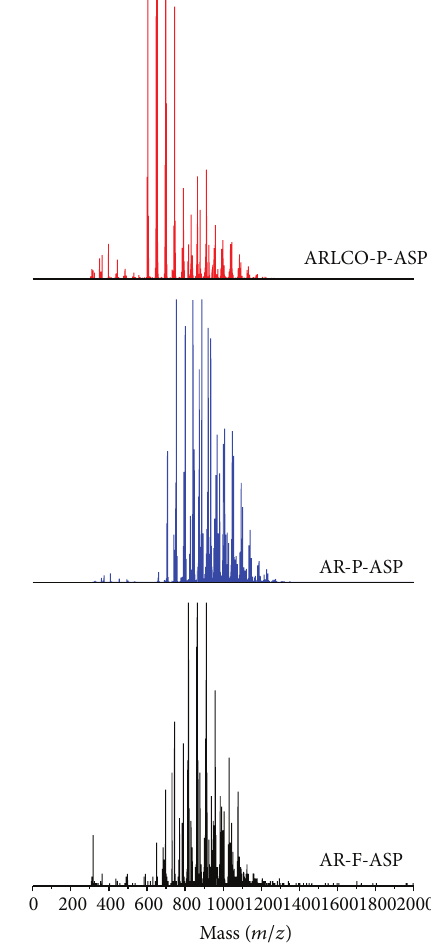
Figure 1: TOF-MS spectra of asphaltenes before and after